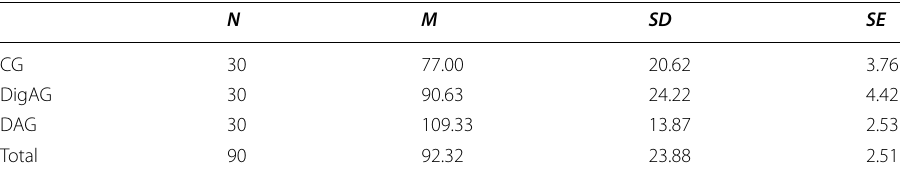
Table 18 Descriptive statistics of anxiety posttest of all groups